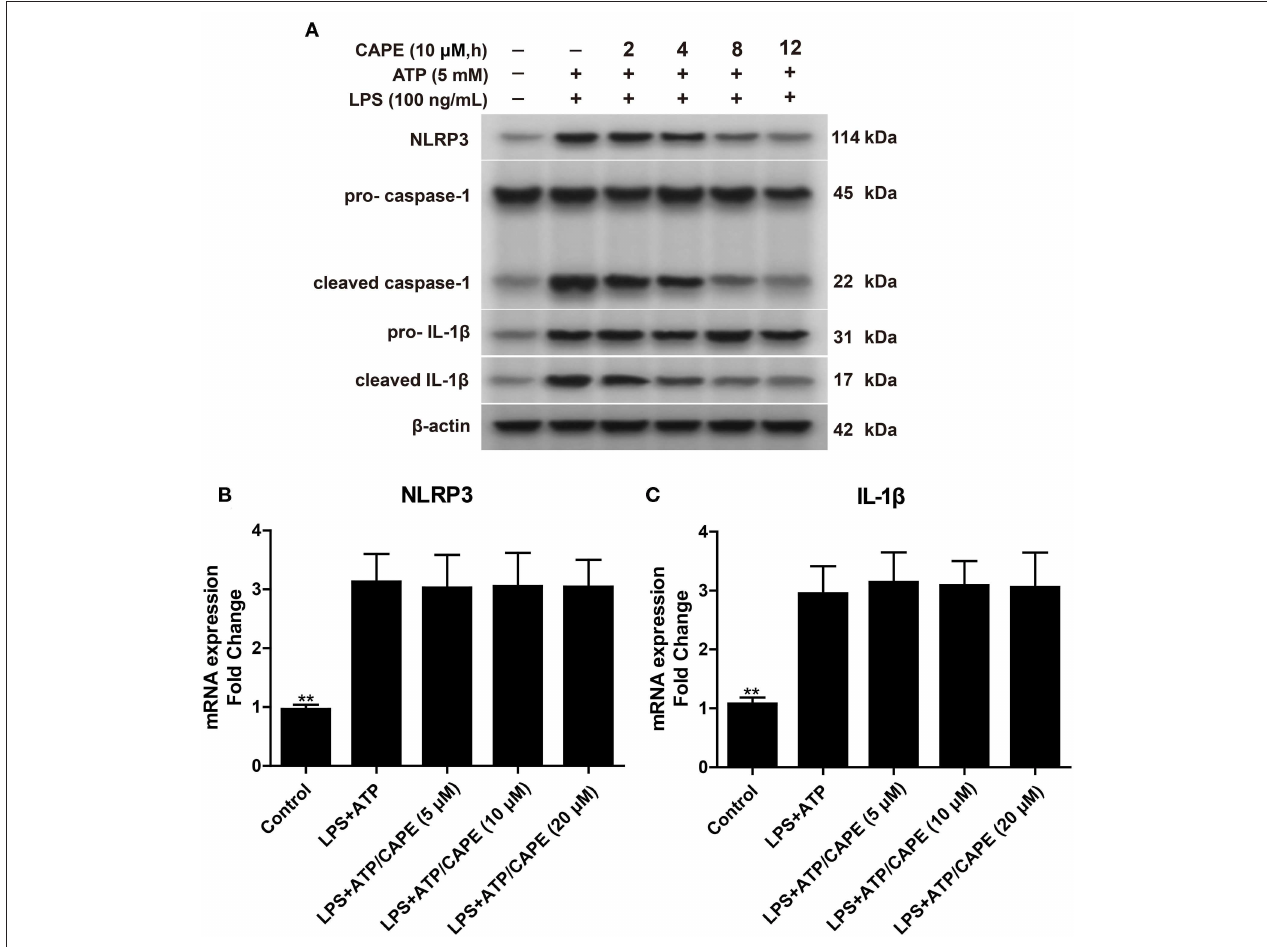
FIGURE 2 | CAPE does not affect mRNA levels of NLRP3, despite altering its protein levels. (A) Effect of CAPE on the expression of NLRP3, cleaved caspase-1, pro-caspase-1, cleaved IL-1 β , and pro-IL-1 β in THP-1 cells. (B,C) mRNA levels of NLRP3 and IL-1 β were detected by real-time PCR after CAPE treatment for 12h. Data are presented as mean ± SD ( n = 3). ** P < 0.01 vs. LPS + ATP